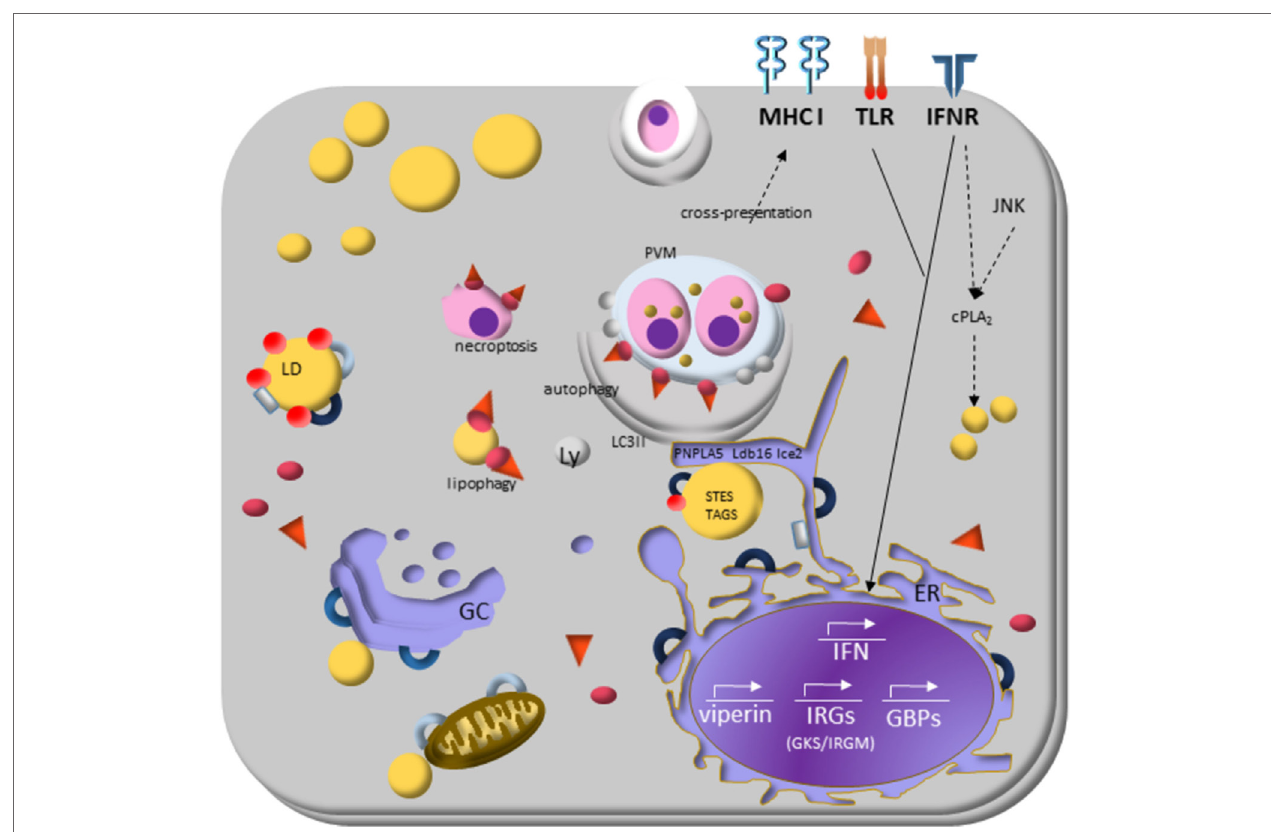
FiGURe 3 | Lipid droplets (LDs) and the molecular mechanisms regulating immune response during protozoan infection. Interferon (IFN)- γ receptor signaling induces transduction of GTPases family molecules—immunity-related GTPases (GKS e IRGM proteins) and GPBs subfamilies—that play essential roles in membrane vesicular trafficking, autophagy, and antimicrobial and anti-inflammatory responses. IRGM are abundant proteins on LDs and “protects self-vesicles” from GKS and guanylate binding proteins (GBPs) destruction by autophagy machinery. The inactive GKS and GBP proteins built a pool of molecules available on cytoplasm and could have a stable association with the IRGM-deficient membrane, as parasitophorous vacuole membrane and eventually as LDs, to target them to autophagy, or lipophagy, respectively. LDs provide fatty acids, and lipids employed the phagophore membrane, implying their enzymes [steryl esters (STEs) and TAGs] on autophagosome biogenesis. IFN- γ signaling induces upregulation of LDs, and it appears to involve perilipin 2 (PLIN2)/ADRP that physically associates with IRGM. LD is also related to cross-presentation pathway since depletion of LDs by pharmacological inhibition of DGAT and by PLIN2/ADRP deficiency led to decreased LD biogenesis and cross-presentation since MHC-I surface expression, and the rate of antigen-presenting cell conjugated with T CD8 + lymphocyte are